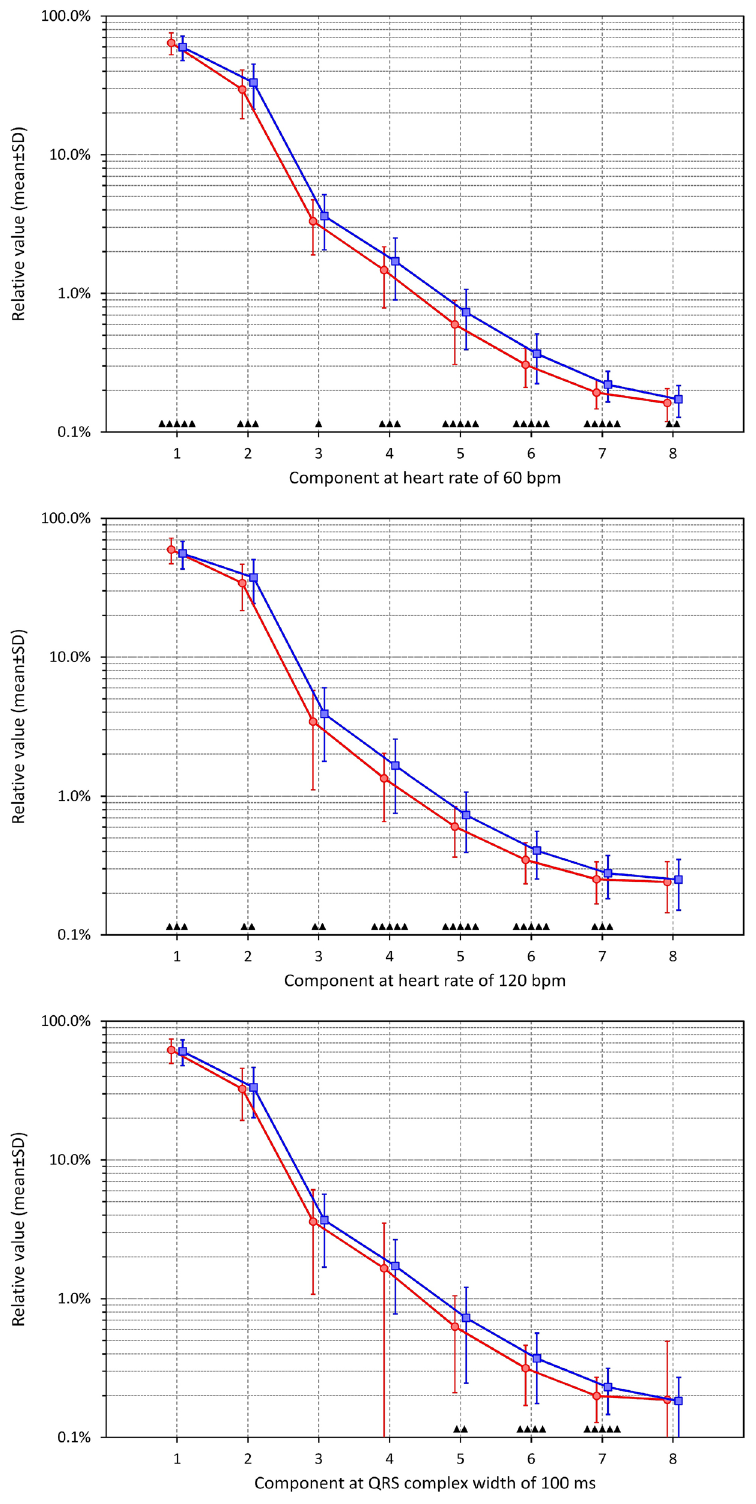
Figure 12. The panels show the mean (± standard deviation) values of decomposition components ∇ 1 to ∇ 8 for female (red graphs) and male (blue graphs) subjects. The top, middle, and bottom panels show the values of components assessed at 60 bpm heart rate, 120 bpm heart rate, and 100 ms of QRS duration, respectively. For each component showing statistically significant difference between females and males, the level of significance is shown above the horizontal axis ( ▲ —p < 0.05, ▲▲ —p < 0.01, ▲▲▲ —p < 0.001, ▲▲▲▲ —p < 0.0001, ▲▲▲▲▲ —p < 0.00001). Note the logarithmic scale of the vertical